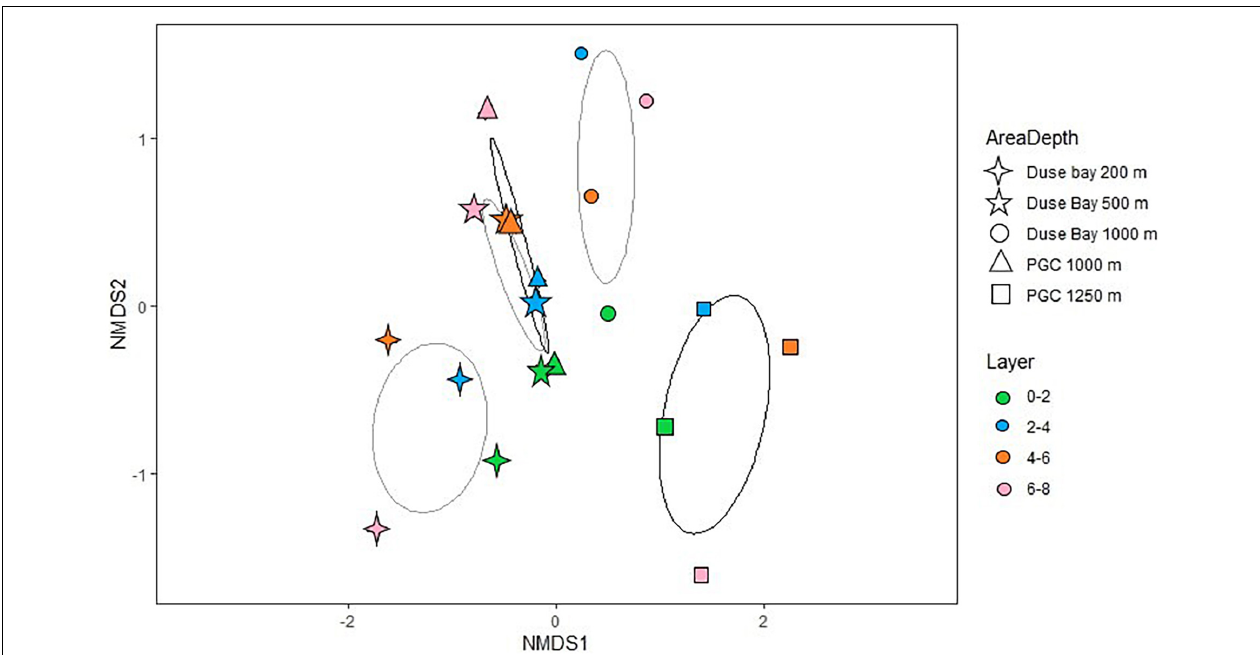
FIGURE 5 | Non-metric Multi-dimensional Scaling analysis performed on the ASVs dataset (three to four replicates per station, all layers considered). The lighter ellipses represent the Duse Bay area, while the darker ones belong to the PGC stations. The further segregated ellipses (lower part of the graph) belong to DB 200 m and PGC 1,250 m, whereas an overlap between DB 500 m and PGC 1,000 m is clearly visible, with DB 1,000 m located closer to the “middle stations.”